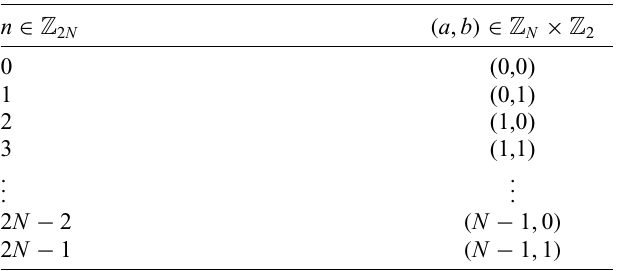
TABLE III. An alternative labeling of the elements of Z 2 N by elements of Z N × Z 2